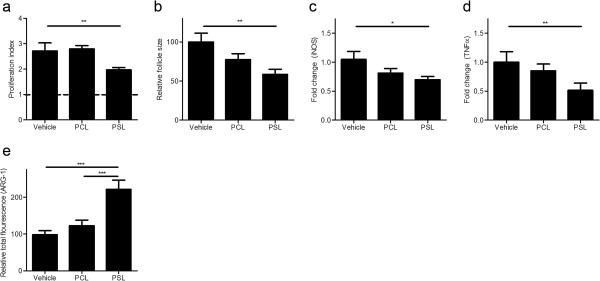
PSLs affect splenic cognate antigen specific proliferation and expression of TNFα, iNOS and ARG-1. (a) Cognate antigen specific proliferation (10 dpi) of splenic cultures was assessed by culturing splenic cells from vehicle, PCL and PSL treated animals with MOG. Proliferation was assessed by [3H]thymidine incorporation. Non-stimulated cultures were used as control (dotted line). Data represent the mean ± SEM of four experiments. (b) The size of the splenic white pulp was determined using ImageJ software. Three cryosections per animal were stained with CD200R, a marker for myeloid cells, after which the surface area surrounded by the marginal metallophilic macrophages was determined. Five images (4× magnification) per section were taken to calculate the mean white pulp size. Data represent the mean ± SEM of four animals. (c,d) Comparison of fold changes between vehicle, PCL and PSL-treated spleens 10 dpi. Relative quantification of iNOS (c) and TNFα (d) was accomplished by using the comparative Ct method. Data were normalized to the most stable reference genes, determined by Genorm (Pgk1 and Rpl13a). Data represent the mean ± SEM of 4 experiments. (e) Spleen cryosections were stained with ARG-1 after which the total corrected fluorescence was determined using ImageJ software, as described previously [65]. Three cryosections were stained and 6 images (10× magnification) were taken per section. Data represent the mean ± SEM of four animals.